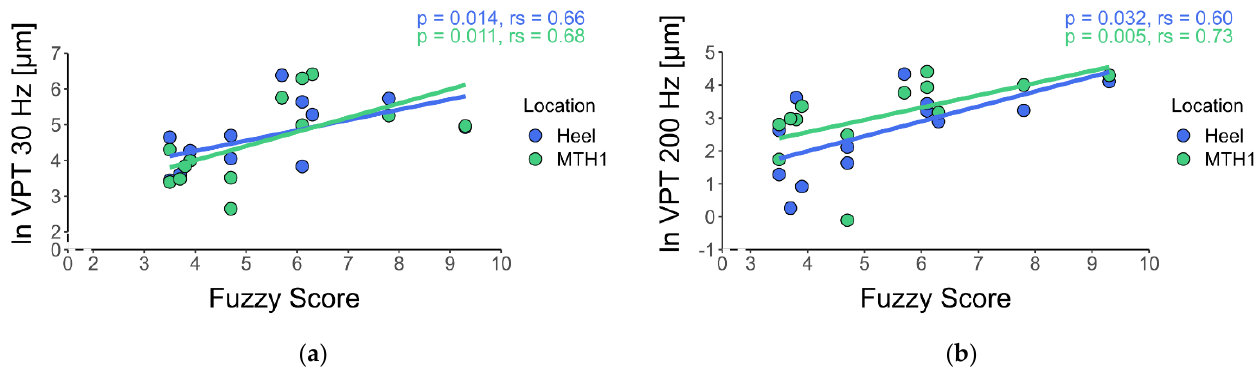
Figure 2. Correlation analysis between VPTs of the DPN group and fuzzy score. ( a ) correlation analysis between VPT at 30Hz and the fuzzy score, ( b ) correlation analysis between VPT at 200Hz and fuzzy score.